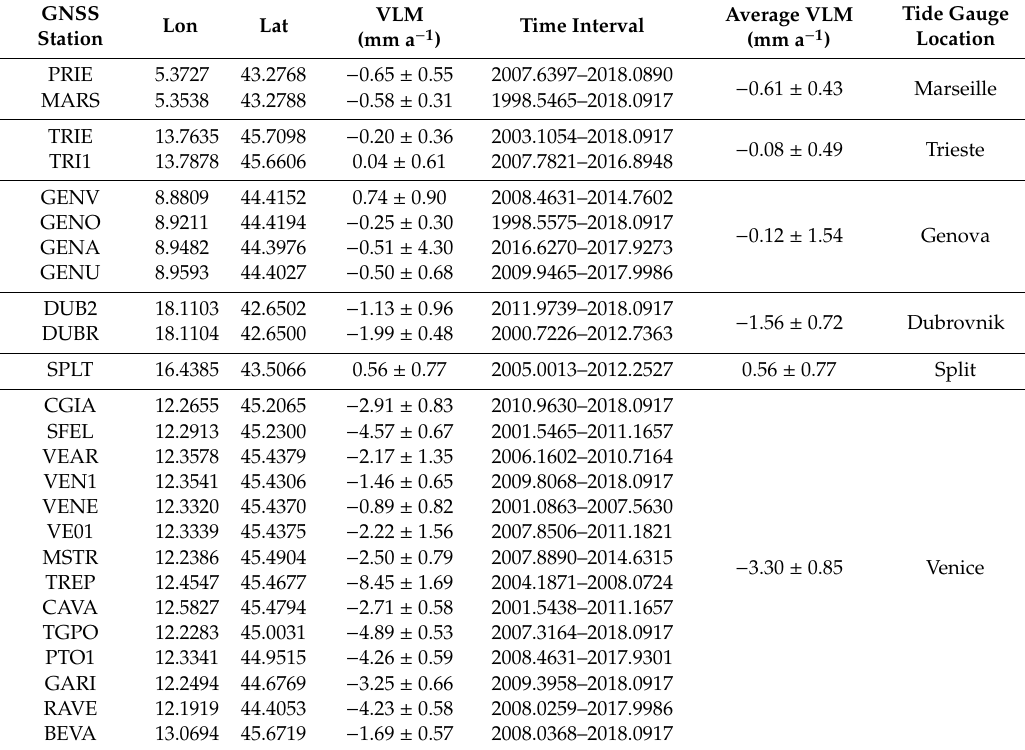
Figure 5. Map of the absolute (i.e., IGb08 frame) vertical velocities for the continuous GPS (cGPS) stations used in this work. Black dots refer to the stations ROGS (Bakar) and RIGS (Rovinj) for which, due to the limited available data, calculated vertical land motion (VLM) are not reliable. Table 3. VLM measured at the cGPS station closest to the tide gauges used in this work. The cGPS station name, position, rate of VLM, time interval of the time series, mean VLM, and the closest tide gauges to the cGPS stations are indicated. Negative sign in the VLM corresponds to land